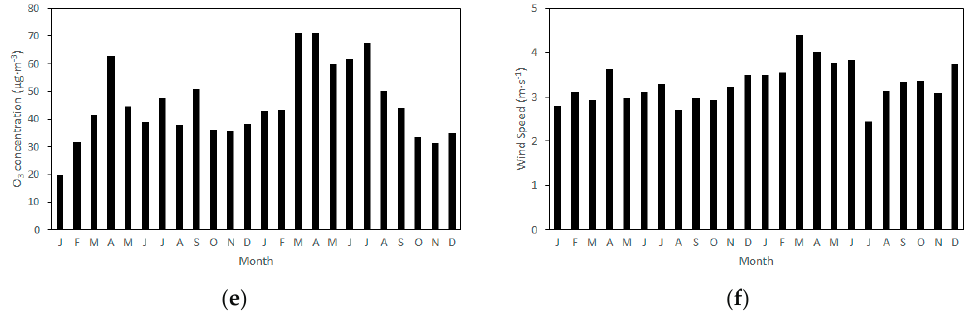
Figure 4. Monthly average values of ( a ) NO concentrations, ( b ) temperature, ( c ) NO 2 concentrations, ( d ) relative humidity, ( e ) O 3 concentrations, and ( f ) wind speed.